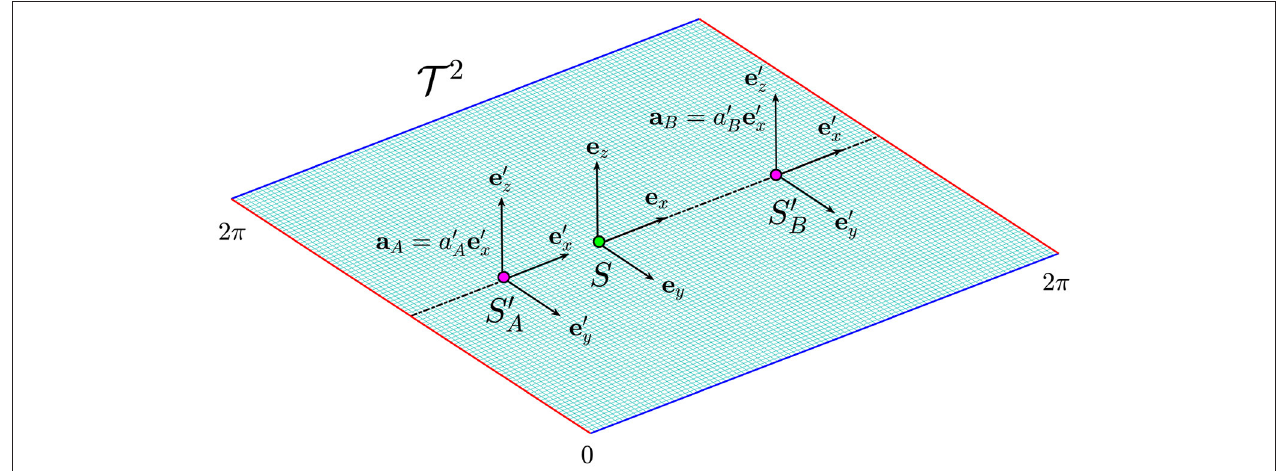
FIGURE 6 | The flat torus T 2 in which the dynamics of Alice ( S ′ A ) and Bob ( S ′ B ) occur along the straight dotted line. The green and the purple dots represent their birth and their actual position on the manifold. The effect of time dilation is more evident for Alice whose frame of reference moves at higher acceleration.